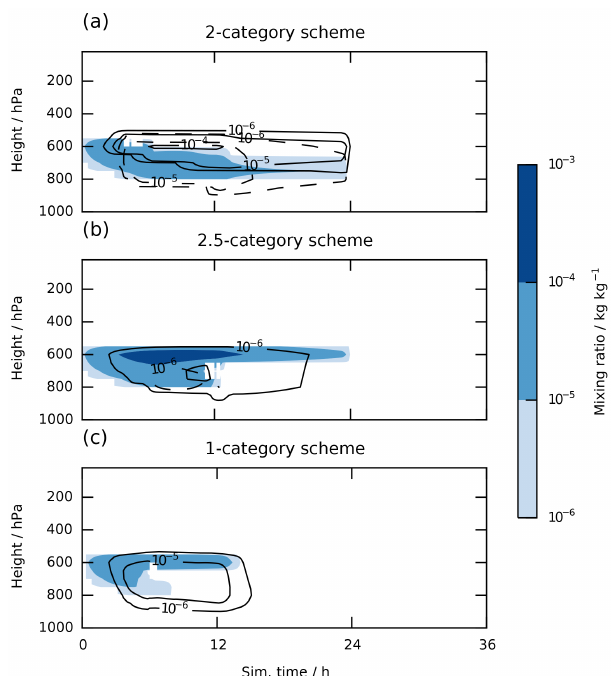
Figure 9. Time series of the vertical profiles of in-cloud ice (con- tour lines) and liquid water contents (colors). For the 2-category schemes snow mass is indicated by dashed lines. Note that snow is a vertically integrated quantity and the profile therefore is only an approximation. Panels (a) and (b) show two versions the origi- nal scheme with diagnostic treatment of sedimentation as discussed in the text, and (c) shows the single category with prognostic ice